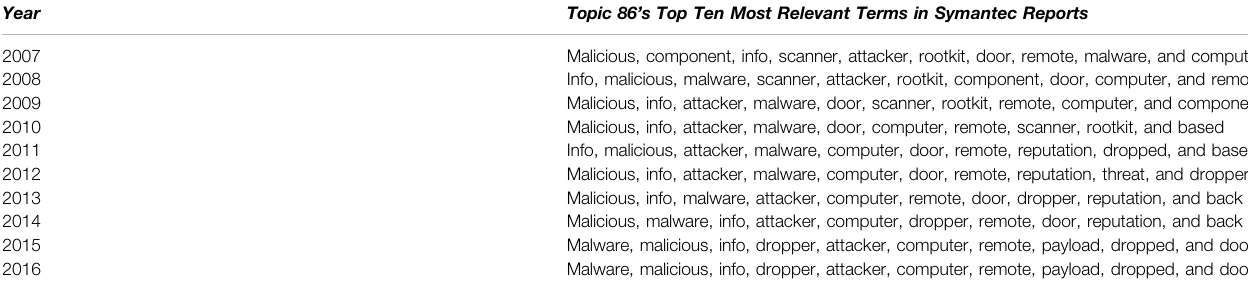
TABLE 6 | 100-topic Symantec Malware report of the dynamic topic model topic 86.